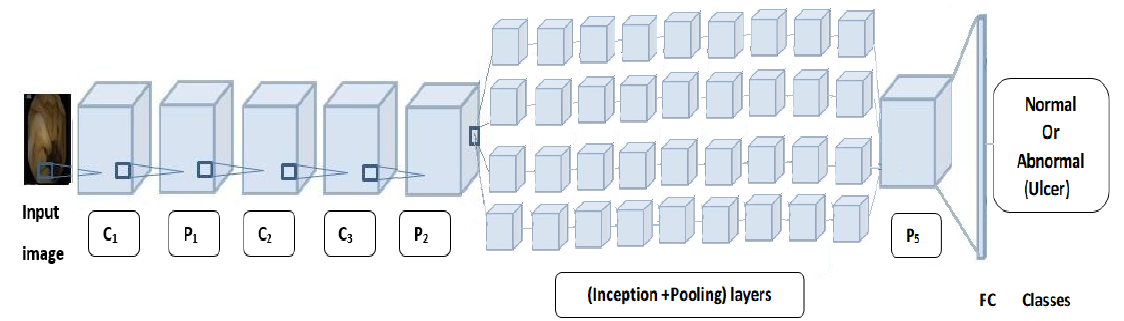
Figure 1. GoogLeNet architecture. Symbols C i refer to convolution layers, P i refer to pooling layers and FC i refer to fully connected layers.